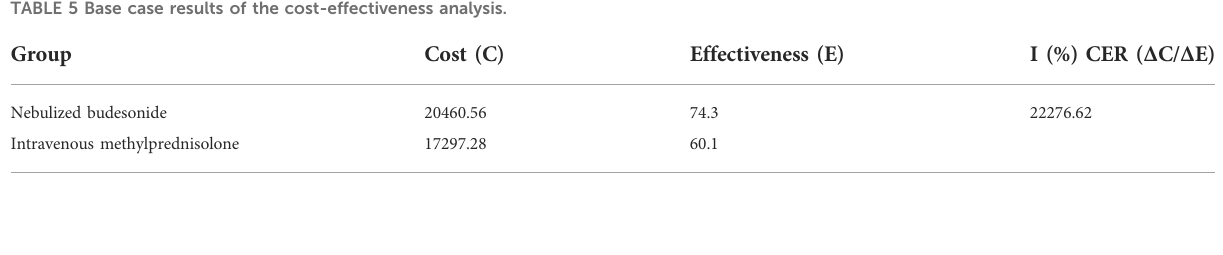
TABLE 6 Logistic regression analysis of treatment